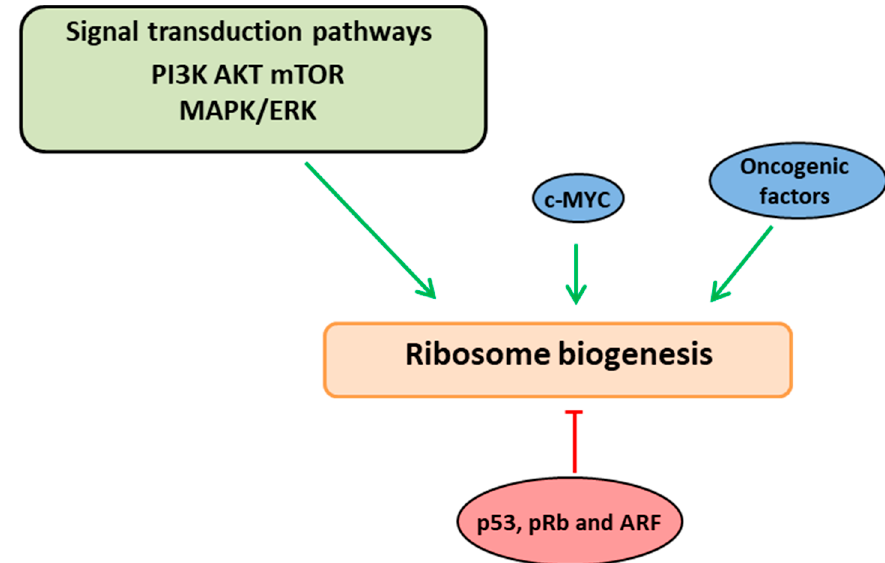
Figure 1. Ribosome biogenesis links with growth and cell proliferation pathways. Ribosome biogenesis is interlinked and coordinated with the cell cycle phases through a series of signaling cascades (PI3K-AKT-mTOR and ERK/MAPK pathways). These pathways induce ribosome biogenesis at various stages by acting directly on RNA polymerases or via the oncogenic factor, c-Myc (indicated in green arrows). Altered ribosome biogenesis is sensed by quality control check points which activate/stabilize the tumor-suppressor proteins (p53, ARF and pRb) resulting in negative regulation of ribosome biogenesis (indicated in red arrow).